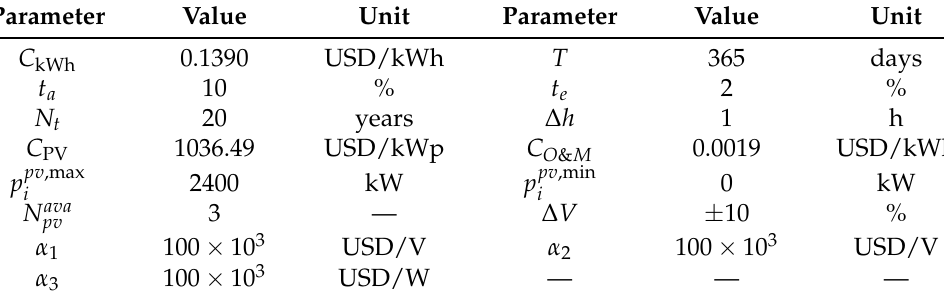
Table 3. Parametrization of the objective and fitness